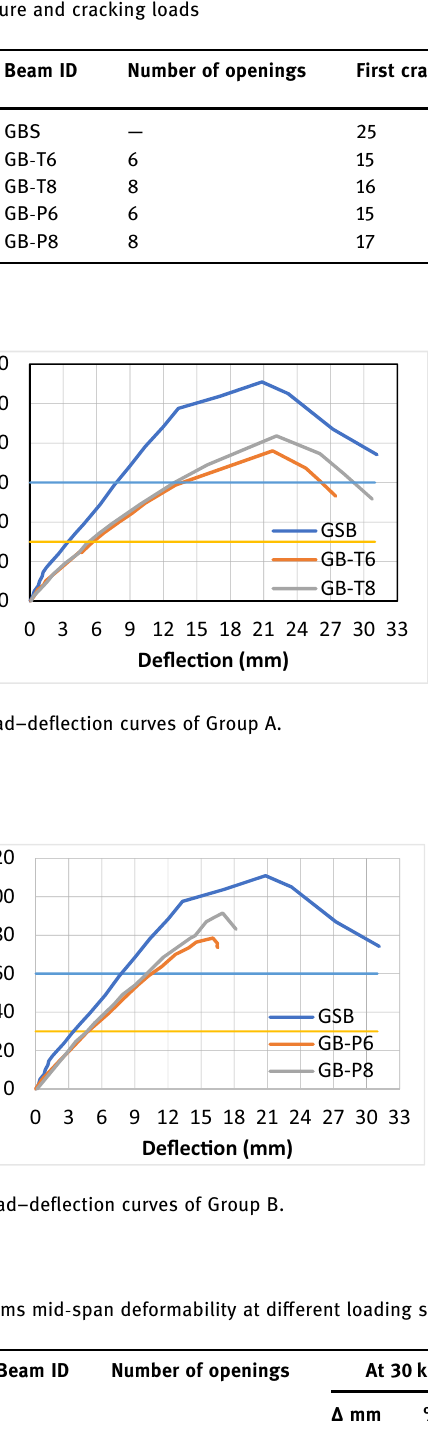
Table 4: Failure and cracking loads